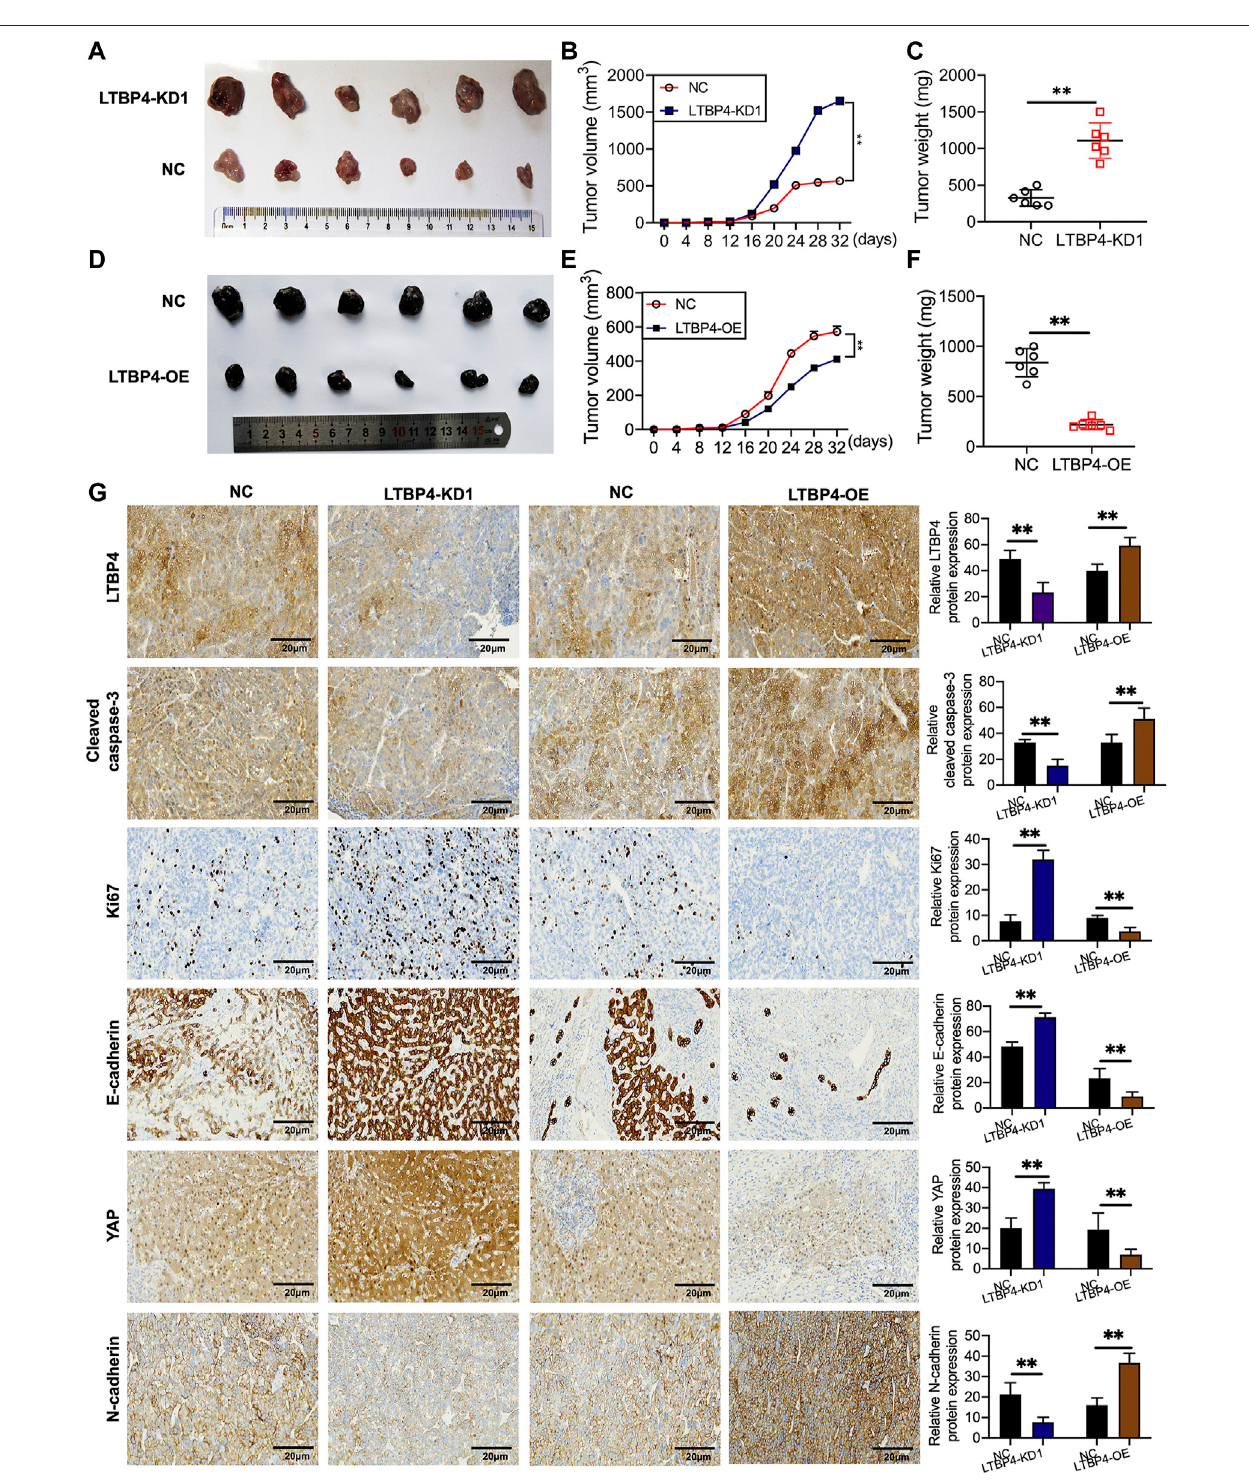
FIGURE 5 | LTBP4 affected the oncogenicity of melanoma cell in vivo . SK-MEL-1 cells transfected with shRNA-LTBP4, or NC were subcutaneously injected into the nude mice, (A) The nude mice were sacri fi ced, and the tumors were collected after 32 days; (B) the volume of the tumors were determined; (C) the weight of the tumors were determined; A101D cells transfected with LTBP4 overexpression or NC were subcutaneously injected into the nude mice, (D) The nude mice were sacri fi ced, and the tumors were collected after 30 days; (E) the volume of the tumors were determined; (F) the weight of the tumors were determined; (G) the expression of Ki67, cleaved caspase-3, Ki67, E-cadherin, YAP, and N-cadherin in the tumors collected from different groups were determined using IHC staining. Data are presented as the mean ± standard deviation. ** p < 0.01 vs NC group.